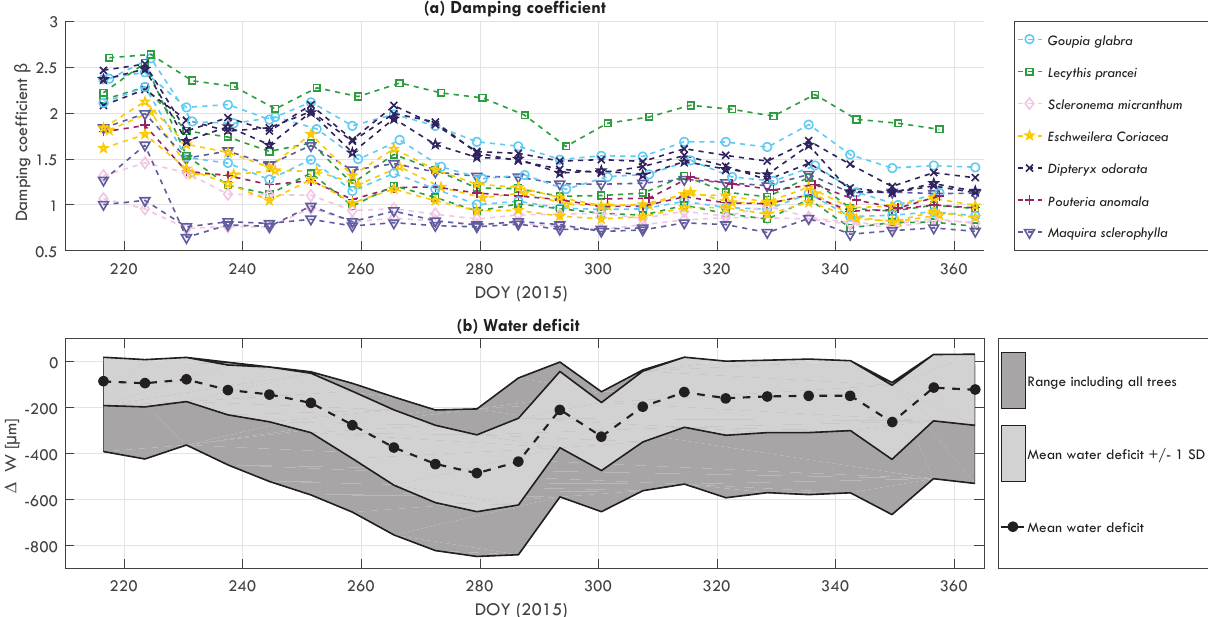
Figure 5. (a) Normalized damping coefficient β for each individual tree, and (b) mean, mean ± 1standard deviation, minimum and maximum water-related stem variation (cid:49)W , for every week from DOY 218 (August) to 365 (December)